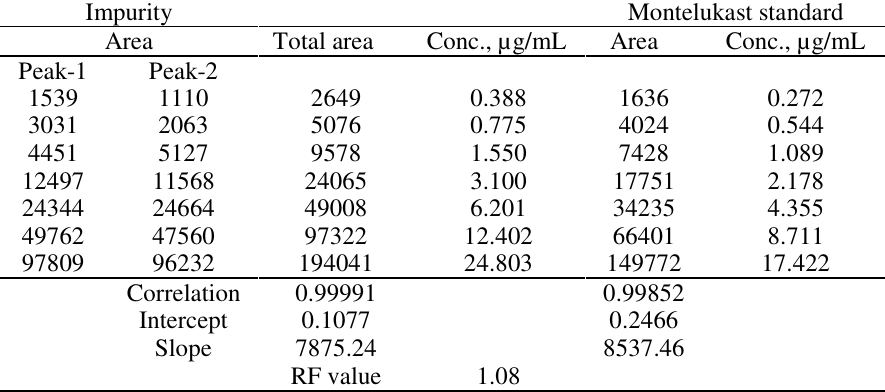
Table 3. Verification for RF value using impurity